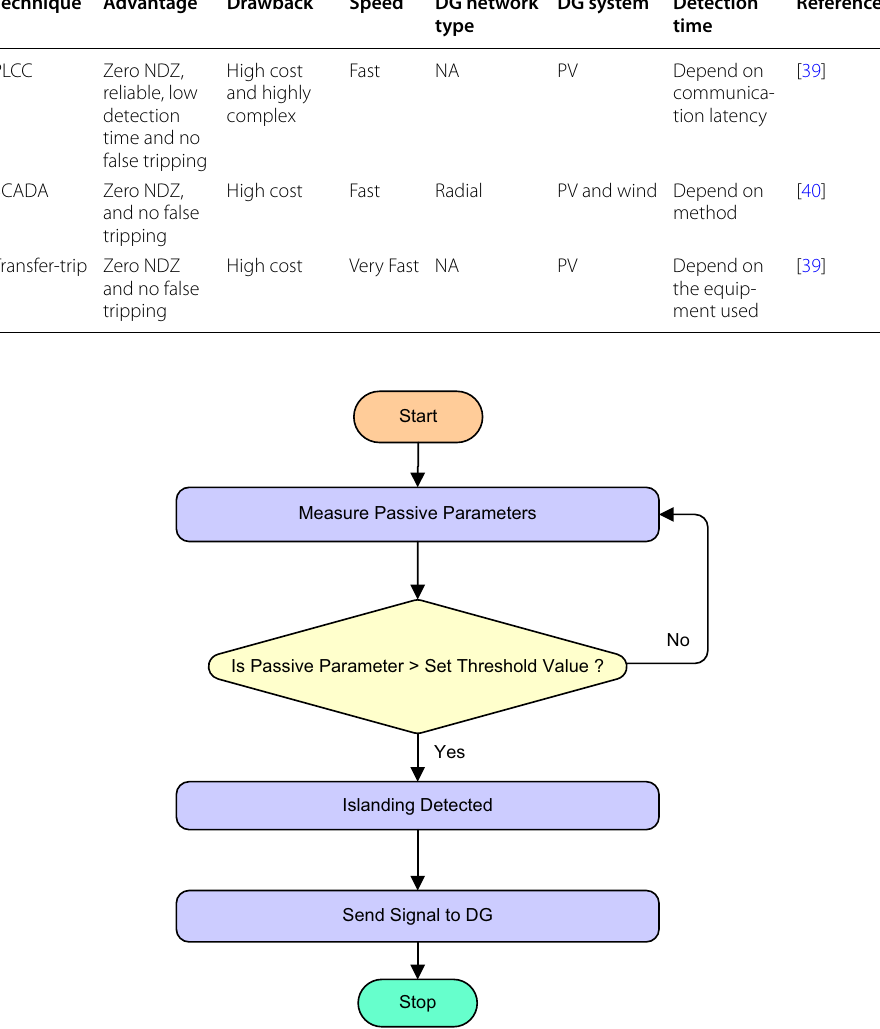
Table 1 Summary of various remote island detection techniques Technique Advantage